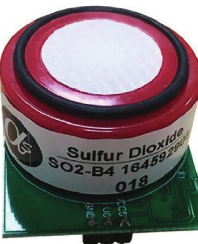
Figure 3: SGA94-SO